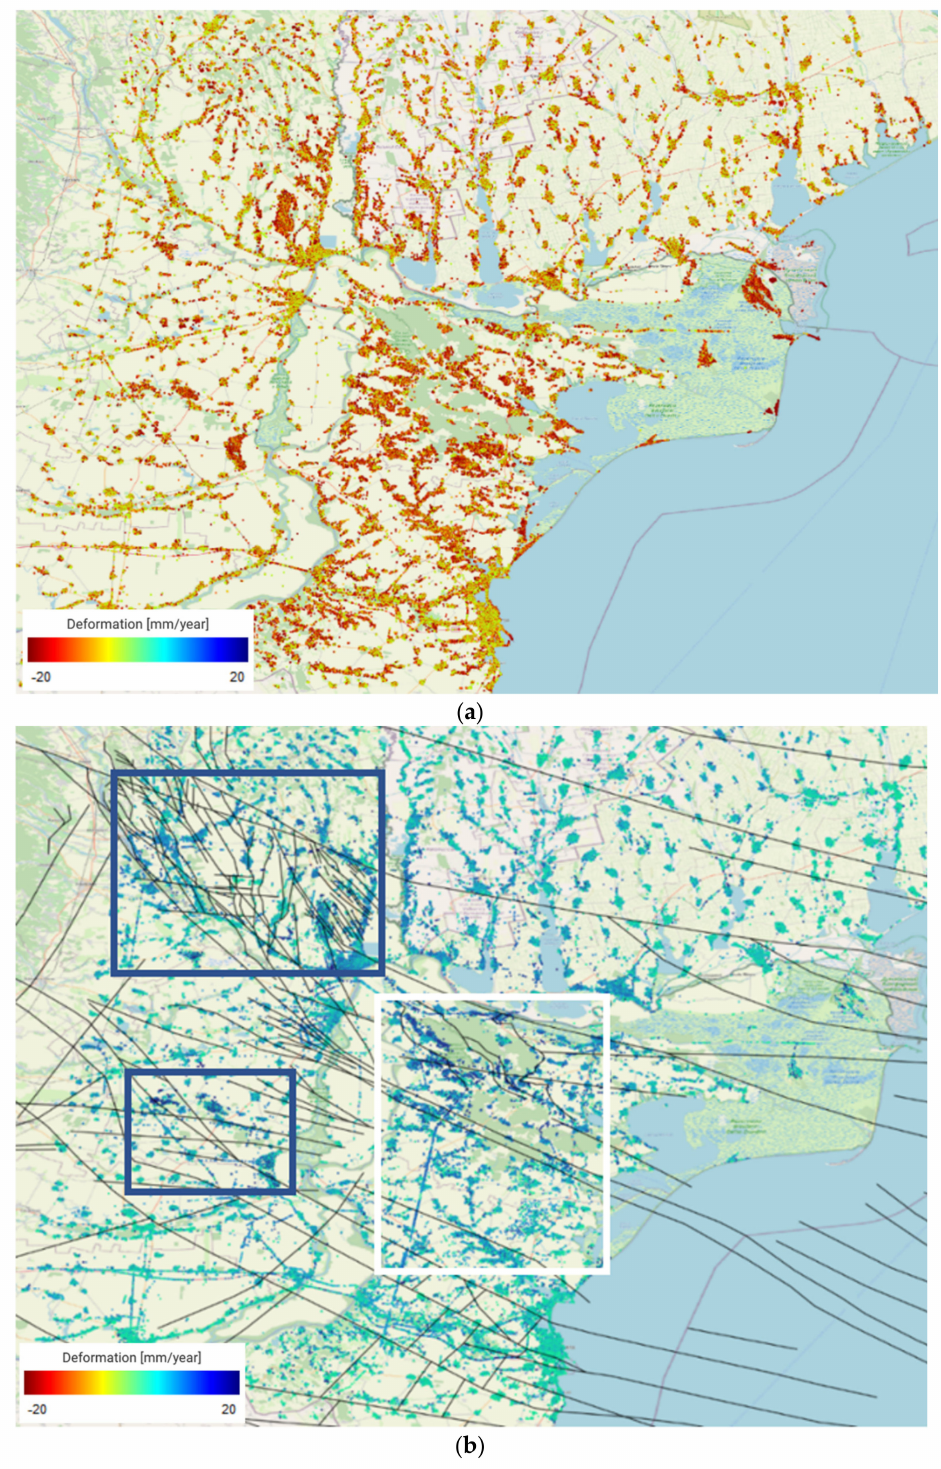
Figure 19. Small-scale motion detection: ( a ) subsidence/westward motion; ( b ) uplift/eastward motion (black lines = local and regional fault systems, from